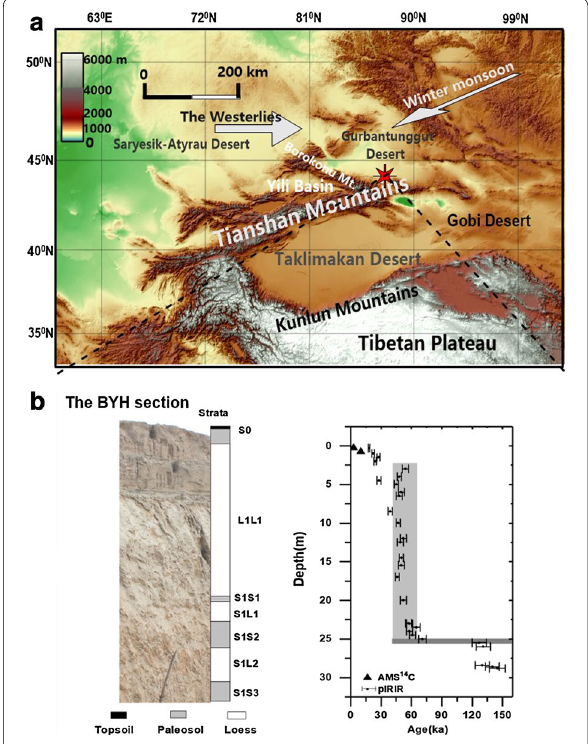
Fig. 1 a Schematic map showing the study area (modified from OpenTopoMap.org) and b sampling overview of the sampling section with main chronological constraints. (Reproduced with permission from Li et al.